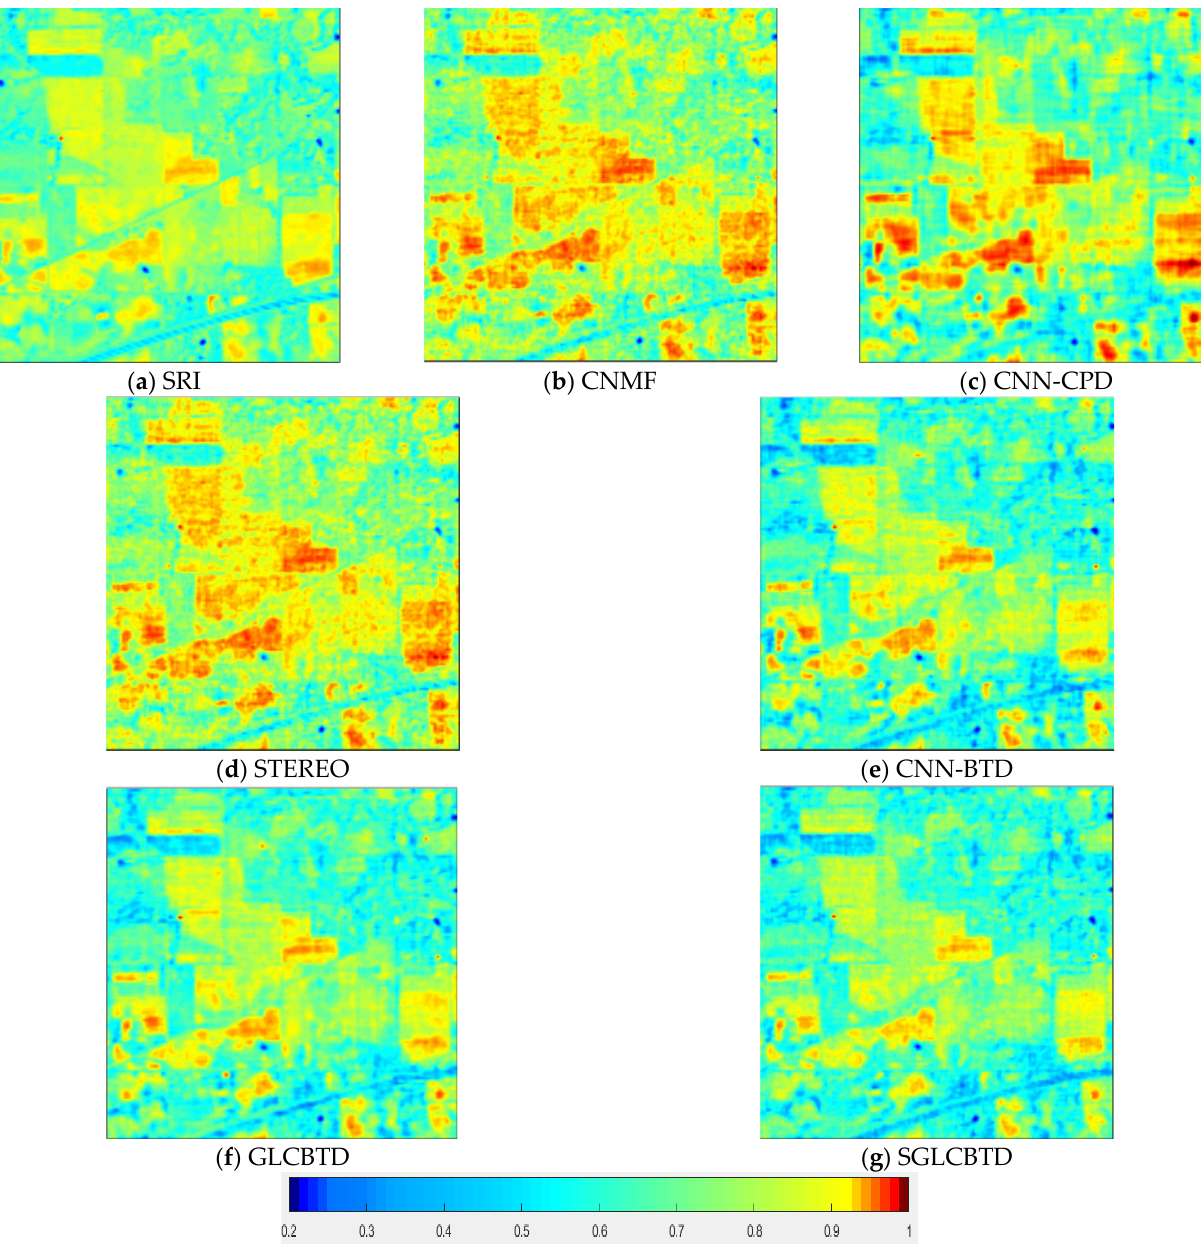
Figure 5. Comparisons of fusion results of the 100-th band on the Indian Pines dataset.